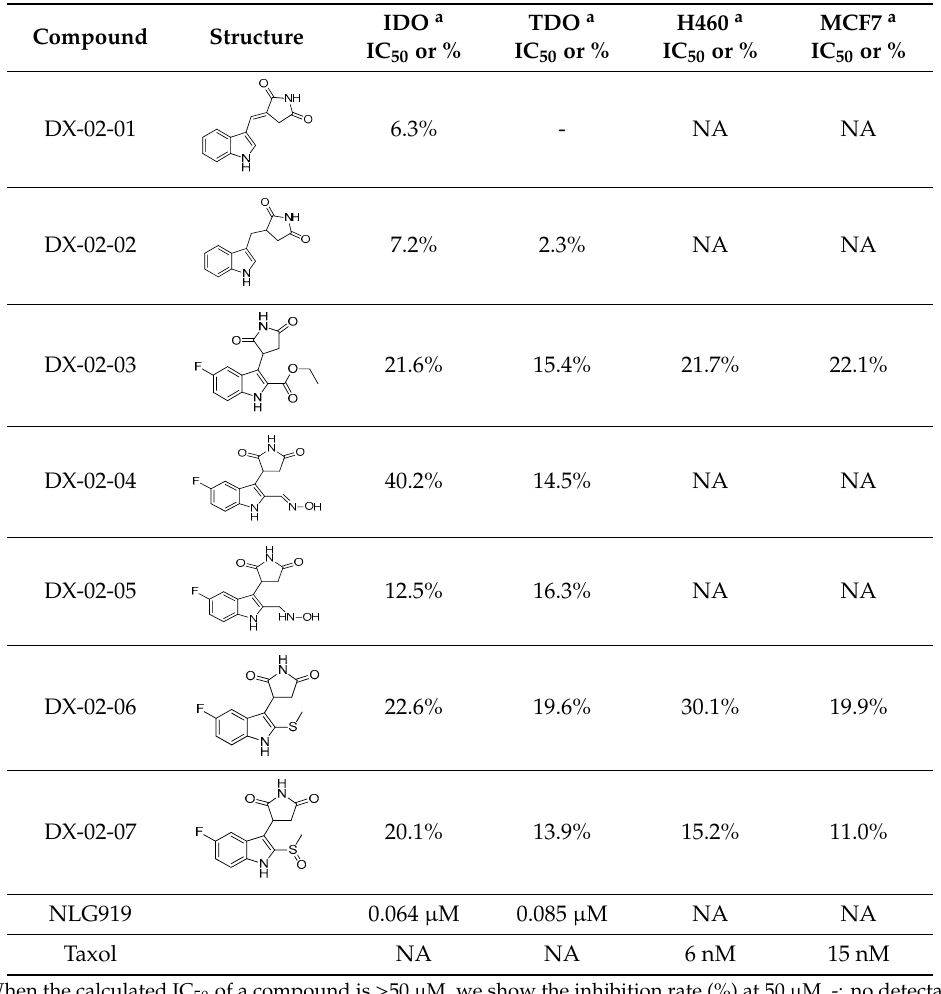
Table 3. In vitro IDO1/TDO inhibitory activities and cell cytotoxicity of series 3.